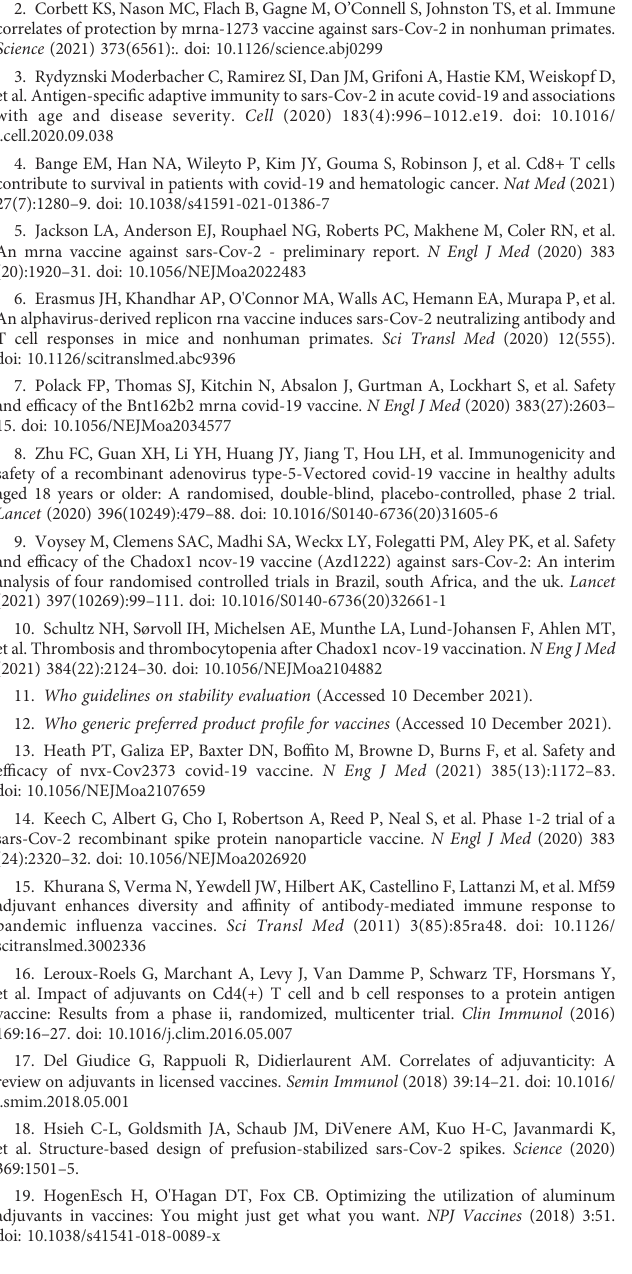
SUPPLEMENTARY FIGURE 1 (A) Representative stainings of lungs from unvaccinated hamsters at 12 days post infection with SARS-CoV-2. In fl ux of different in fl ammatory cells are pointed out. Neutrophils (arrows) and macrophages (arrowheads) are observed. Obj. x 40. (B) Representative stainings of unvaccinated hamsters at 12 days post infection with SARS-CoV-2 for presence of type II pneumocyte hyperplasia, demonstrated by immunostaining of cytokeratin. Obj. x 25. (C) Con fi rmation of antigen (HexaPro) binding to ACE2 by ELISA. SUPPLEMENTARY FIGURE 2 Syrian golden hamsters were immunized with two doses of spike trimer protein alone or formulated in AH and challenged intranasally with 1.8x10 5 TCID 50 of SARS-CoV-2. IgG antibody responses were measured in serum from 12 days